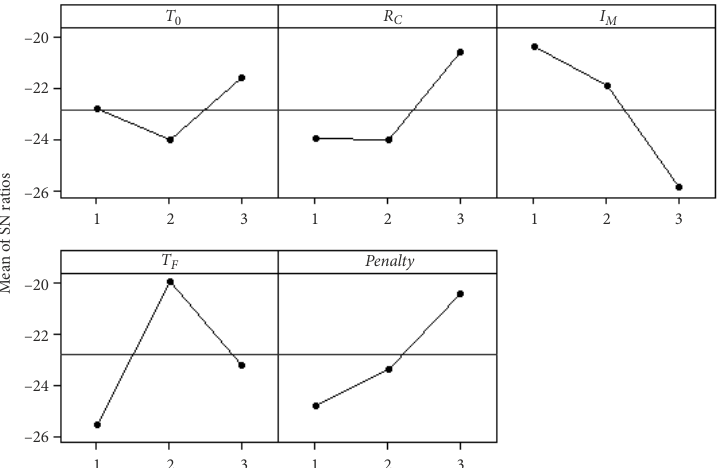
Figure 11. Main effects plot for SN ratio of the GA